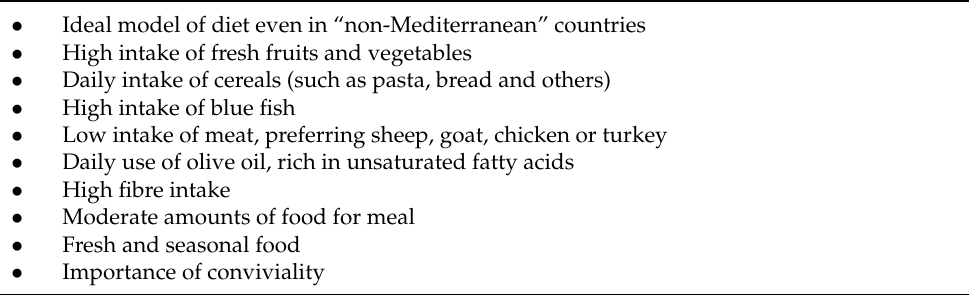
Table 3. Main characteristics of Mediterranean Diet, derived from Widmer Rj et al. [60].